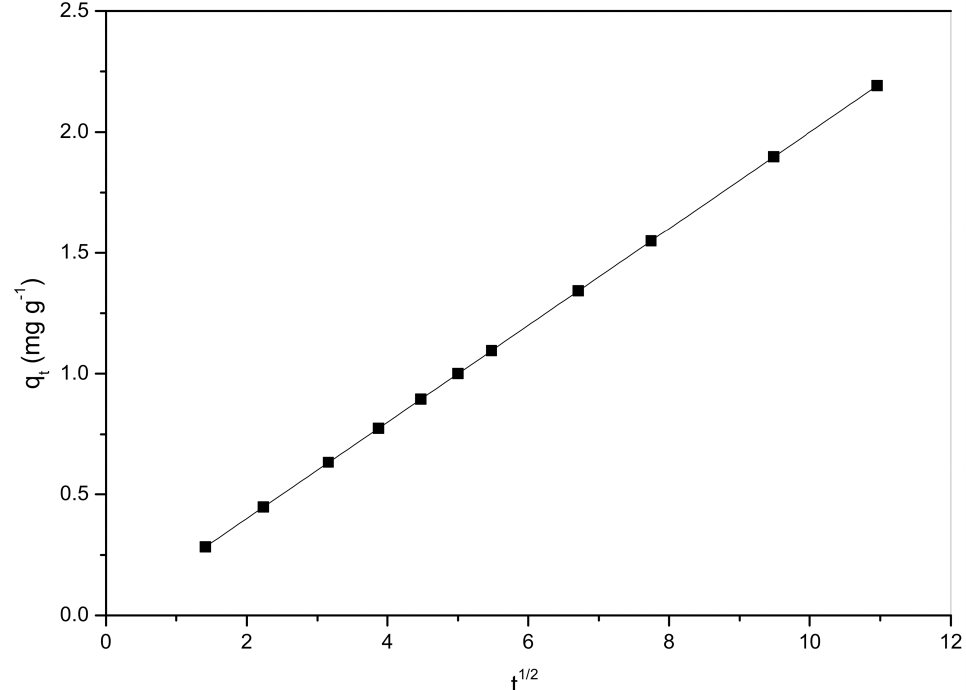
Figure 8. Plots of intra-particle diffusion kinetic model equation for the biosorption of Cd 2 + on the Sargassumfusiforme .